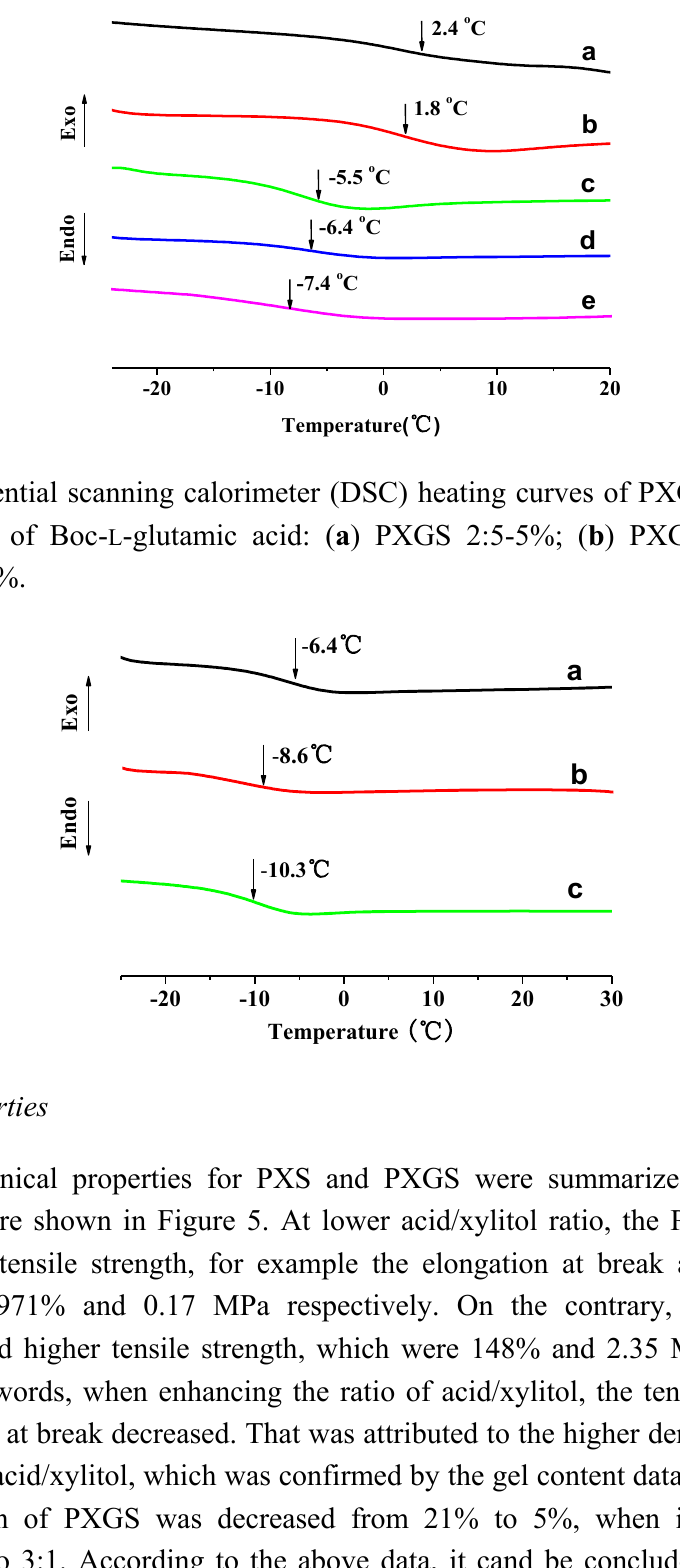
Figure 3. Differential scanning calorimeter (DSC) heating curves of PXGS with various monomer ratios: ( a ) PXGS 1:1-5%; ( b ) PXGS 2:3-5%; ( c ) PXGS 1:2-5%; ( d ) PXGS 2:5-5%; and ( e ) PXGS 1:3-5%.